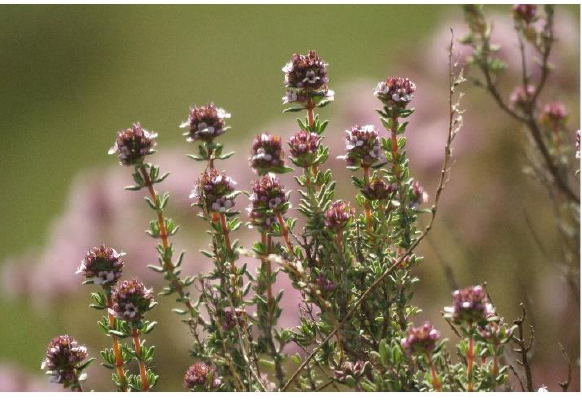
Figure 7. Thymus vulgaris